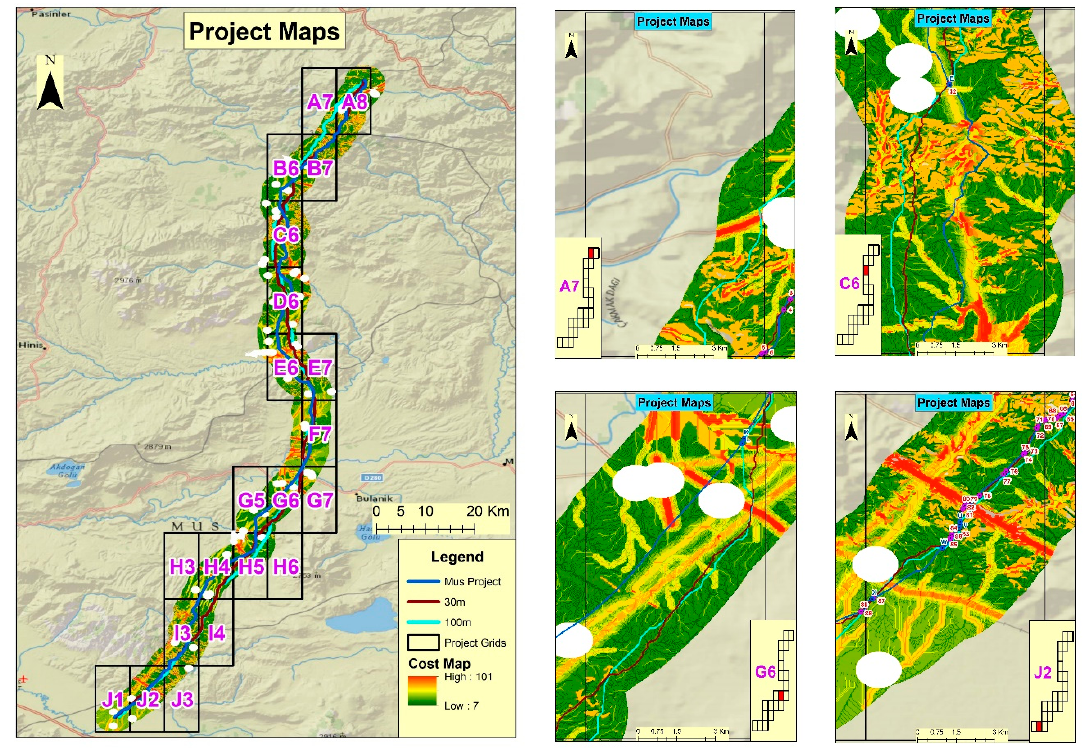
Figure 12. Cost map (base map); the results of 30 m digital elevation model (DEM), 100 m DEM and existing Mu¸s project